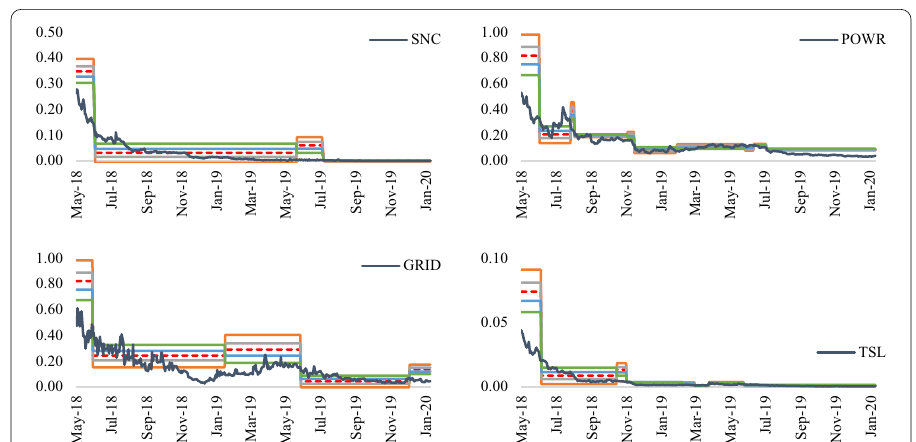
Fig. 9 Energy crypto prices and Fibonacci retracements. Note : This figure represents the 23.6%, 38.2%, 50%, 61.8% and 78.6% (the colour codes are provided in Fig. 7) Fibonacci retracement levels for the leading U.S. energy crypto prices over the period November 2017–January